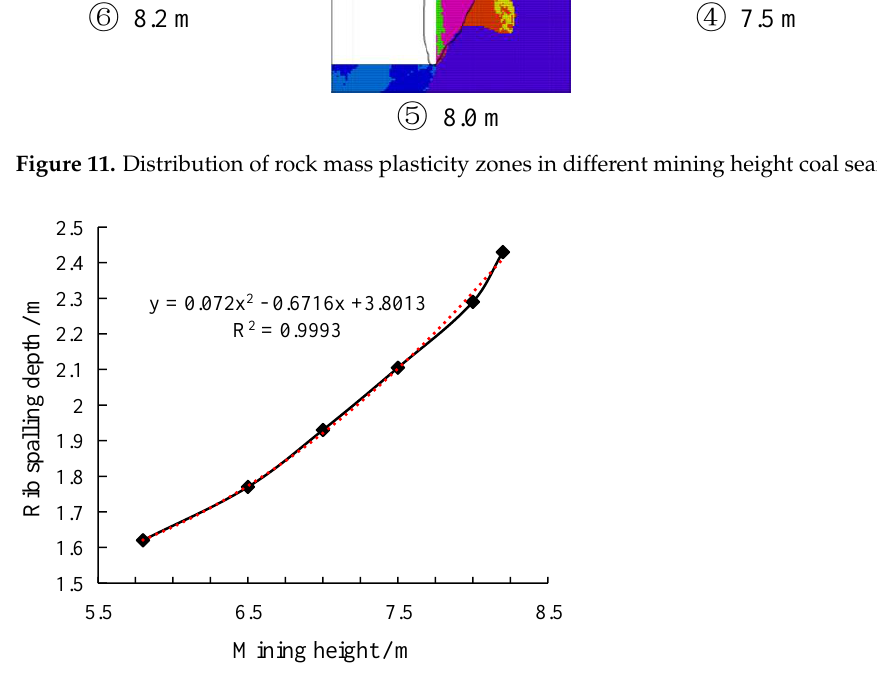
Figure 12. Fitting curve graph of the relationship between the coal seam mining height and coal wall band depth.